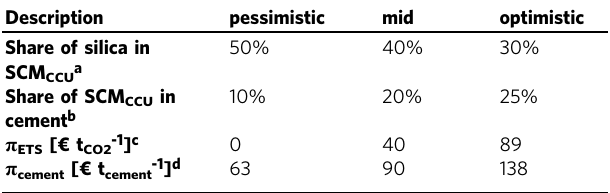
Fig. 1 CO 2 mineralisation (CCU M ) integrated in the cement production process. Unchanged industry labelled in grey/red. CCU M process labelled in light blue/dark blue. Illustration designed by Wernerwerke, Cordes + Werner GbR ©2021. Table 1 Scenario de fi nition for techno-economic evaluation.